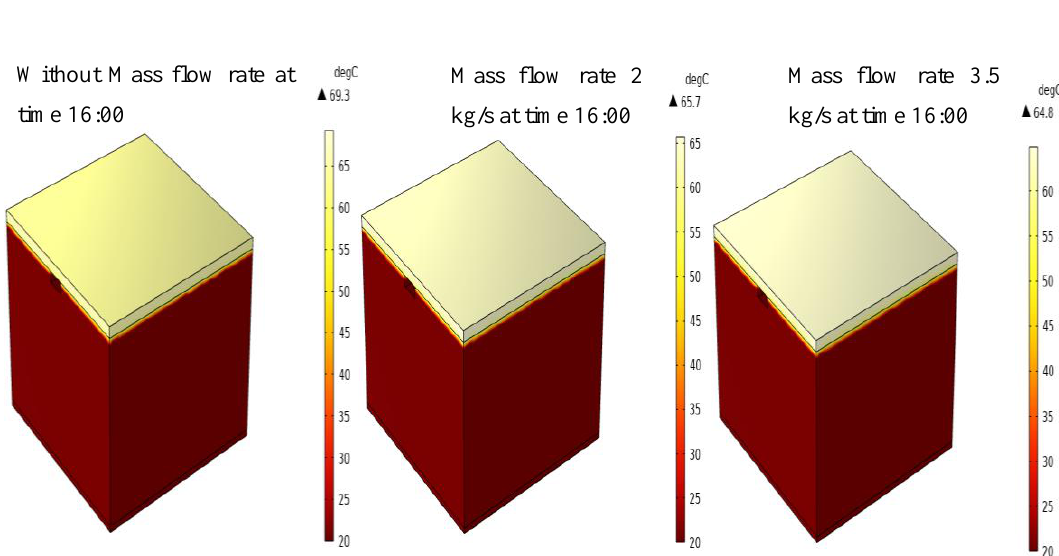
Figure 3. surface roof temperature at the time (16:00) on the days with and without mass flow rates. The graph in Figure 4 shows the temperature under the roof with different mass flow rates. The result showed that when it does not have a mass flow rate, the temperature under the roof was increased until (22:00) and reached (67.68 o C) after that, the temperature also decreased. The results showed that the temperature under the roof gradually increased due to the heat by the concrete roof slowly decreasing heat. Still, when using ventilation to create the mass flow rate with the value of (3.5 kg/s), the maximum temperature was obtained at a time (14:00) with the value of (40.78 oC) after the time (14:00) the temperature was decreased, it is shown that the mass flow rates have an effect on cooling the roofs and also fast the cooling process.